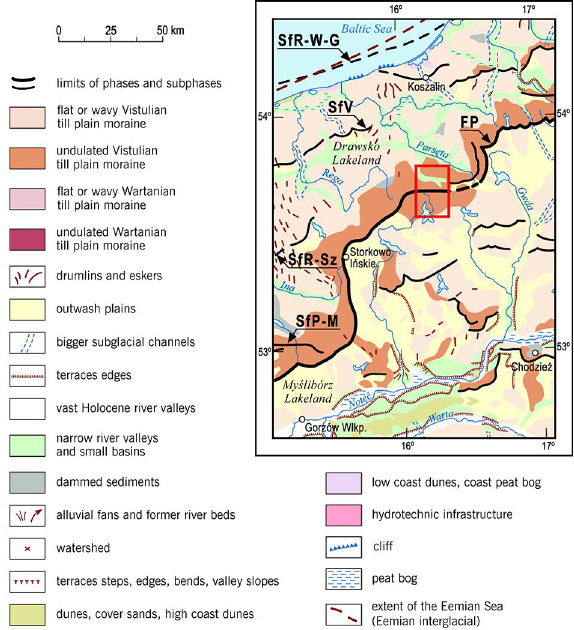
Fig. 1. The location of the planned geopark “Post- Glacial land of the Drawa and Dębnica” (within the red rectangle) on the geomorphological map of the north-western Poland (based upon liedtke 1981, bremer